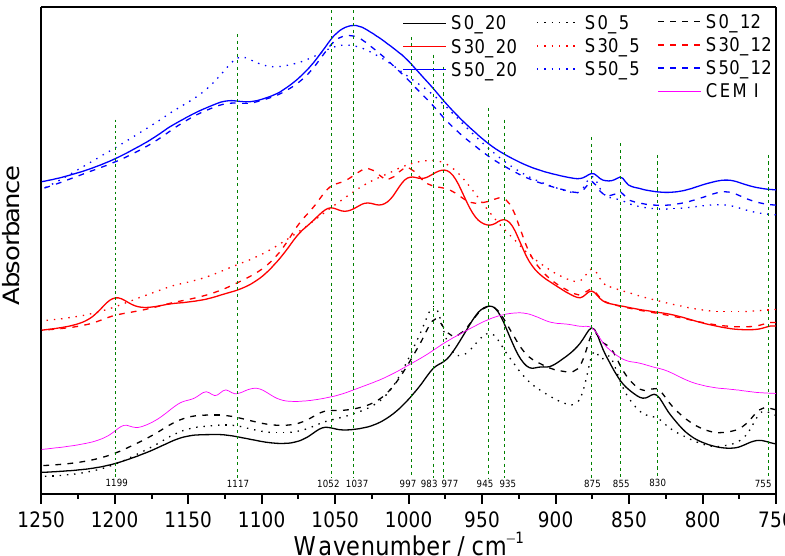
Figure 4. Segment of infrared spectra of all hydrated samples and referential dry cement between 1250 and 750 cm −1 . 1250 and 750 cm − 1